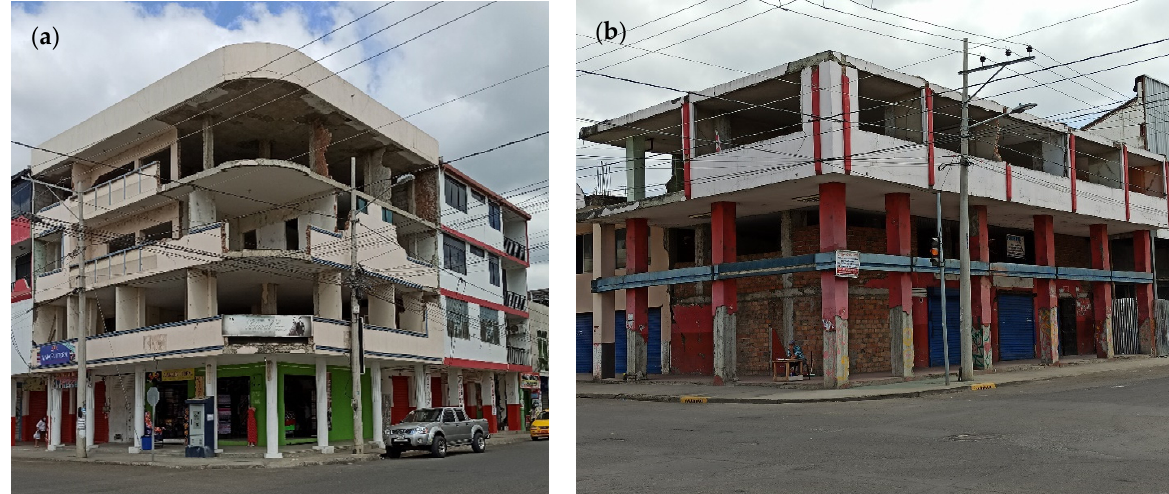
Figure 1. Current status of damaged buildings located on the corners of Chile Street, Portoviejo ( a ) building in use and ( b ) building closed.